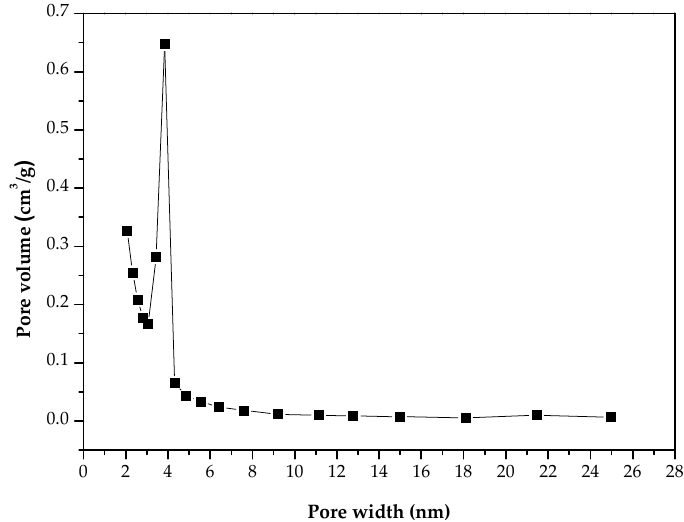
Figure 2. Pore size distribution of resulting activated carbon (WCH-AC).